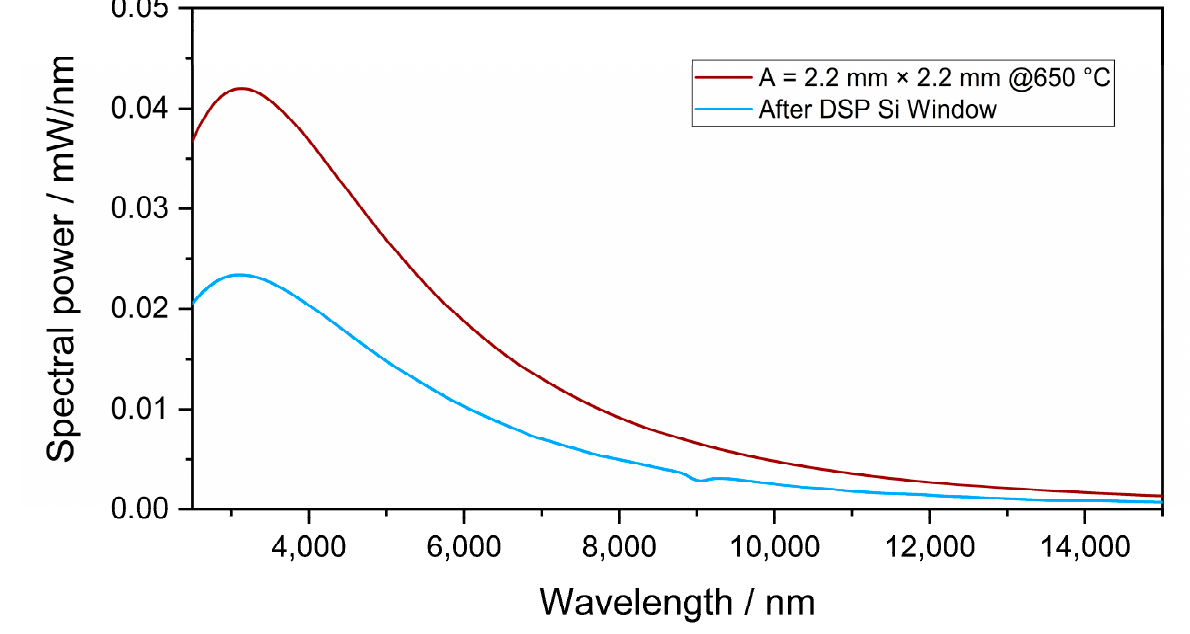
Figure 6. Simulated emitted spectral power of the infrared emitter with an emitter temperature of 650 °C and an active area of 2.2 mm × 2.2 mm and the transmitted spectral power through DSP Si. The simulated sensitivity of each photoacoustic detector to 0–10,000 ppm SO 2 F 2 in the absorption cell (50 mm length) is plotted in Figure 7a. As expected, the highest sensitivity was obtained with the SO 2 F 2 detector. Among the substituents, R227ea showed the highest